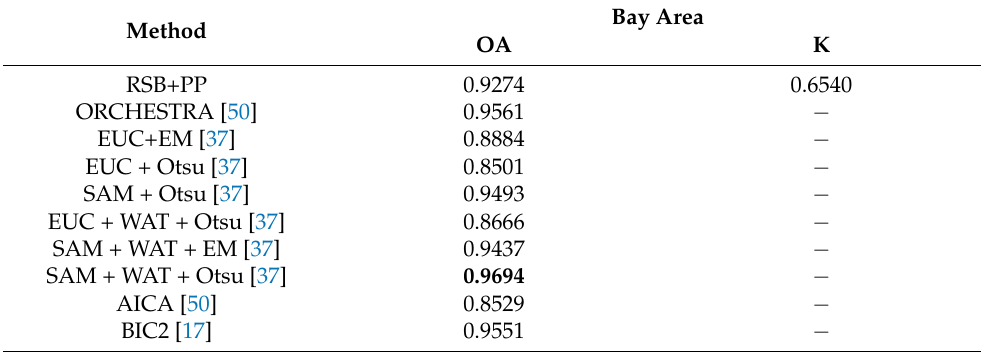
Table 6. The proposed approach, RSB, with post-processing, and other competitors on the Bay Area dataset. The best results are displayed in